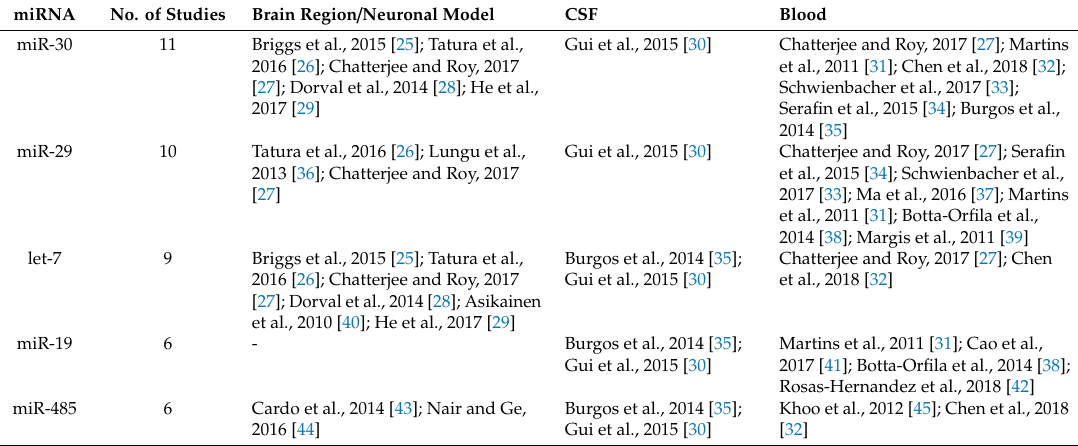
Table 1. Summary of dysregulated miRNAs in PD identified by more than 3 screening studies. miRNA No. of